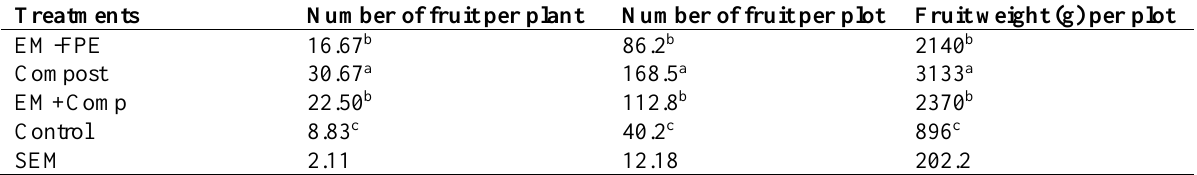
incognita under field conditions Treatments